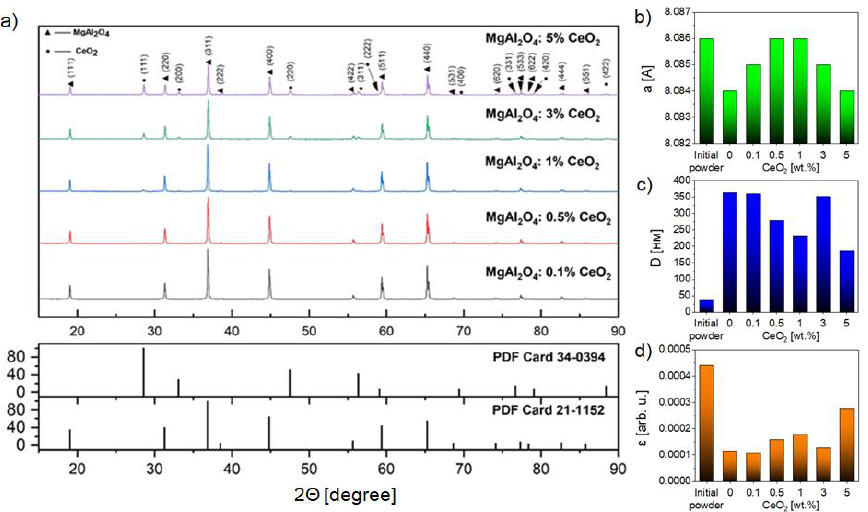
Figure 3. X-ray diffraction patterns ( a ) and the calculated crystal lattice parameters ( b – d ) of MgAl 2 O 4 : х CeO 2 ceramics.